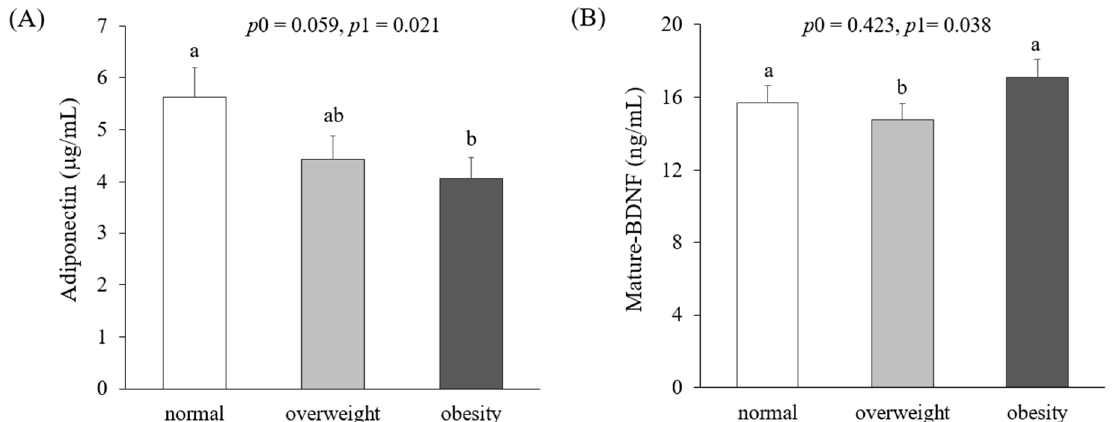
Figure 2. Circulating levels of adiponectin ( A ) and mature-brain-derived neurotrophic factors (BDNFs) ( B ) according to obesity status. Means ± S.E. tested by one-way analysis of variance (ANOVA) ( p 0) and general linear model by Bonfferoni correction with adjustment for age, smoking, drinking, menopausal status, and total calorie intake ( p 1). Sharing the same alphabet letter (a or b) indicates no statistical significance among the